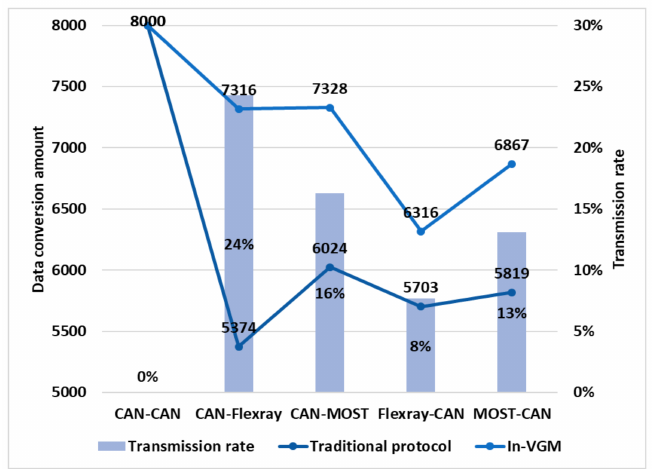
Figure 11. The comparison of the existing in-vehicle protocols with the In-VGM in message transformation